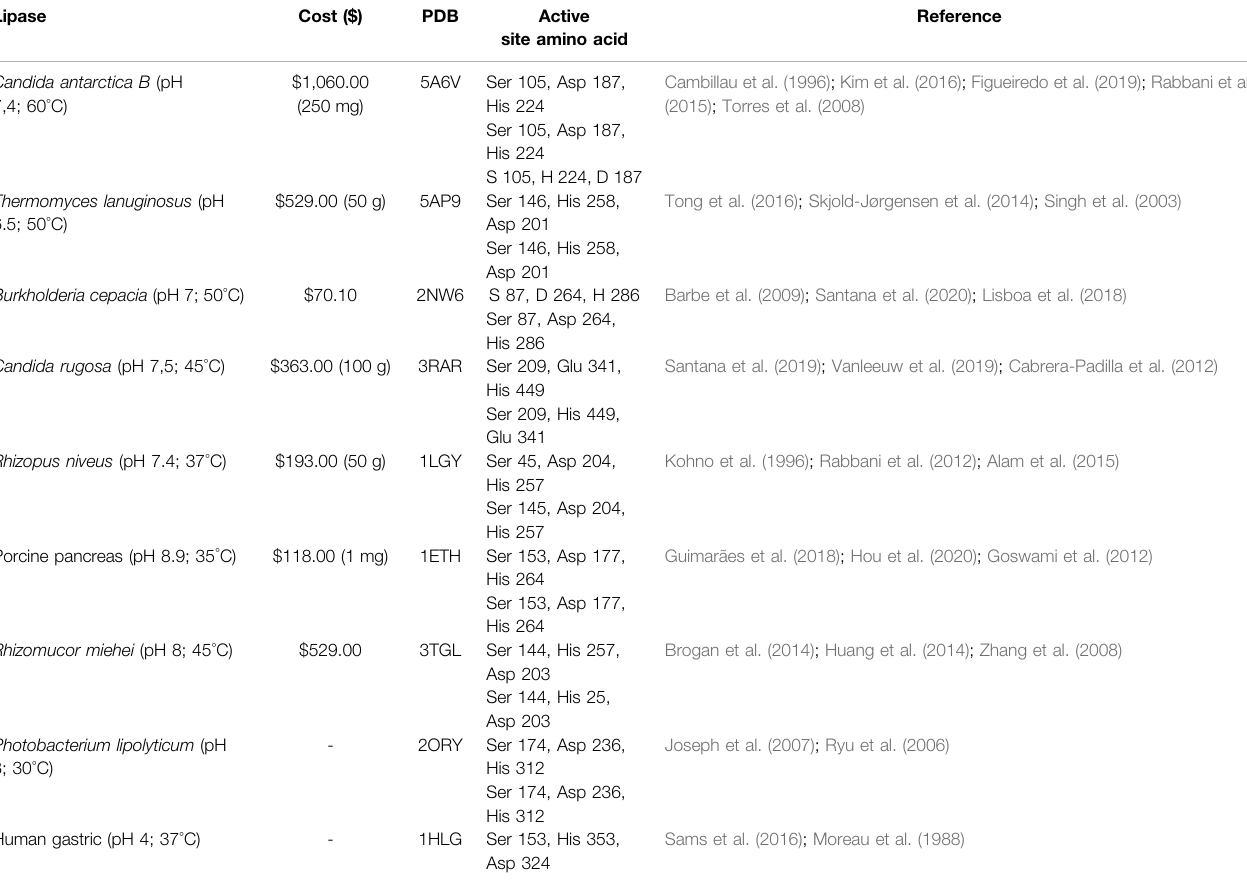
TABLE 1 | Screening of lipases, amino acids corresponding to the respective active sites, and PDB.